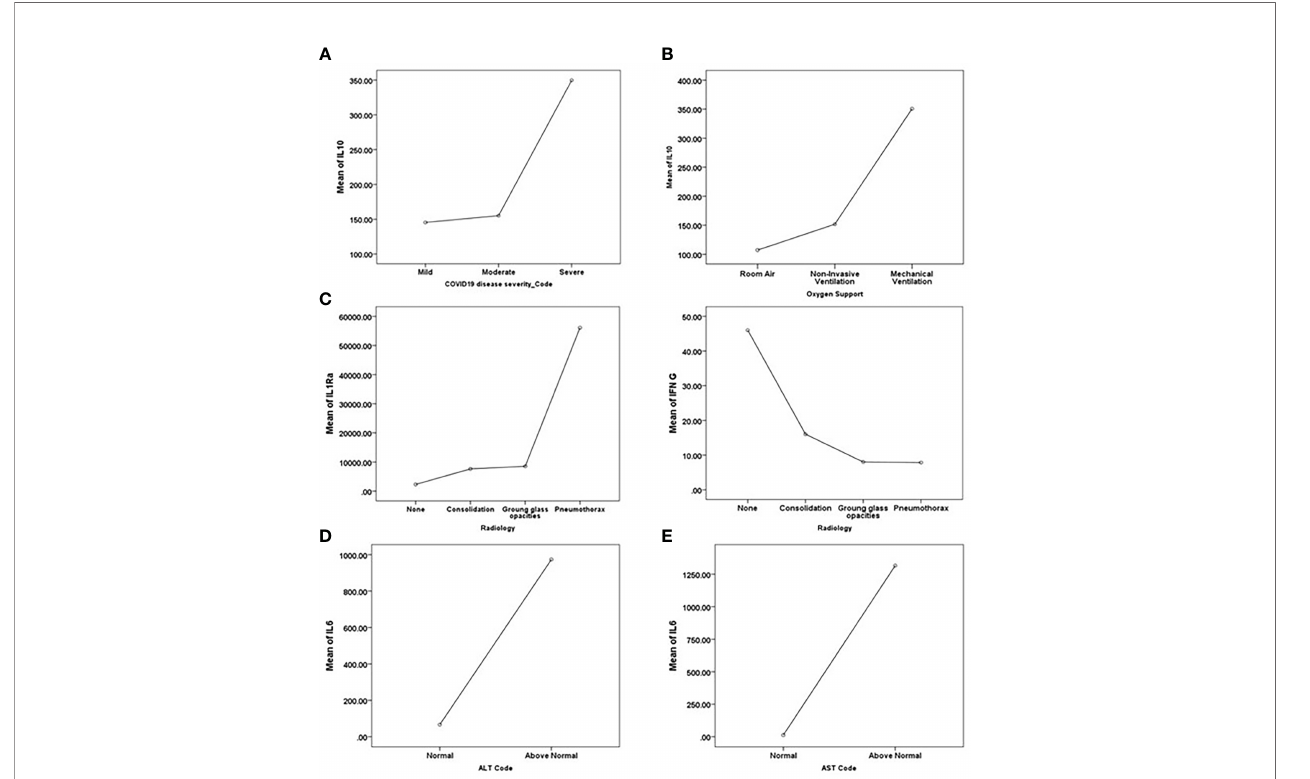
FIGURE 4 | Key driver predictors identi fi ed from Multivariate ANOVA with Bonferroni ’ s stringent multiple testing for (A) disease severity, (B) the requirement for oxygen support, (C) Radiological fi ndings, and (D, E) abnormal liver function indicated by (D) ALT and (E) AST. Means of the predictors ’ levels presented as a function of the target variables